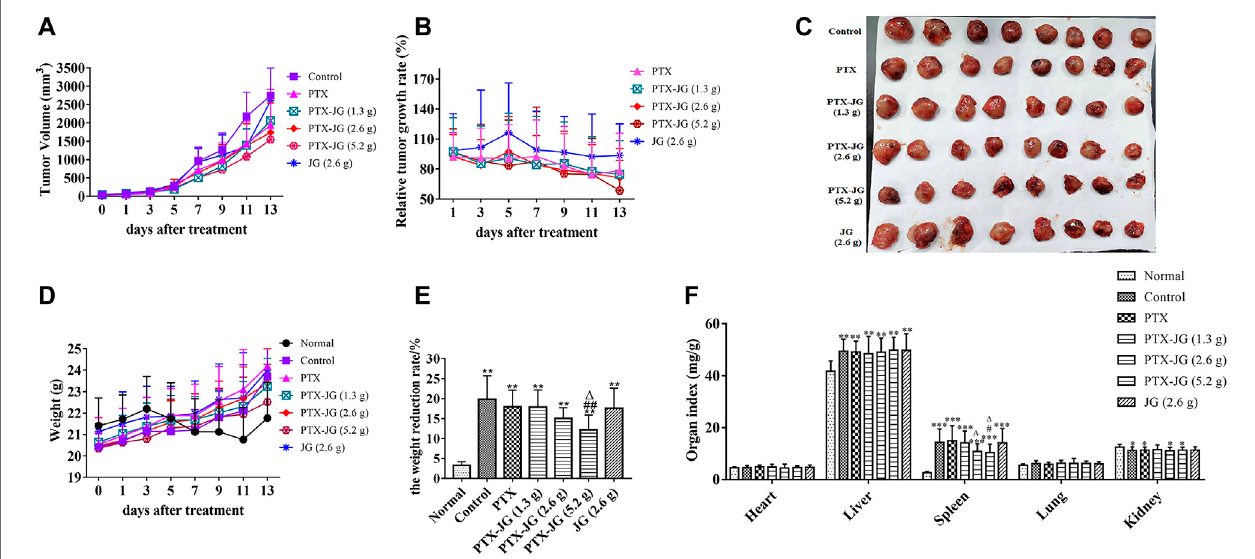
FIGURE 3 | Effect of JG on the anti-lung cancer effect of PTX in Lewis lung cancer mice. (A) : Tumor Volume (n = 12). (B) : Relative tumor growth rate (n = 12). (C) : Tumor morphogram after thecombinationofPTX withJG. (D) : Bodyweight (n=12). (E) :Weightreduction rate(n=12). (F) :Organ indicesofmice after thecombination of JG and PTX (n = 15). * p < 0.05, ** p < 0.01, vs Normal group; # p < 0.05, ## p < 0.01, vs Control group; △ p < 0.05, △△ p < 0.01, vs PTX group.